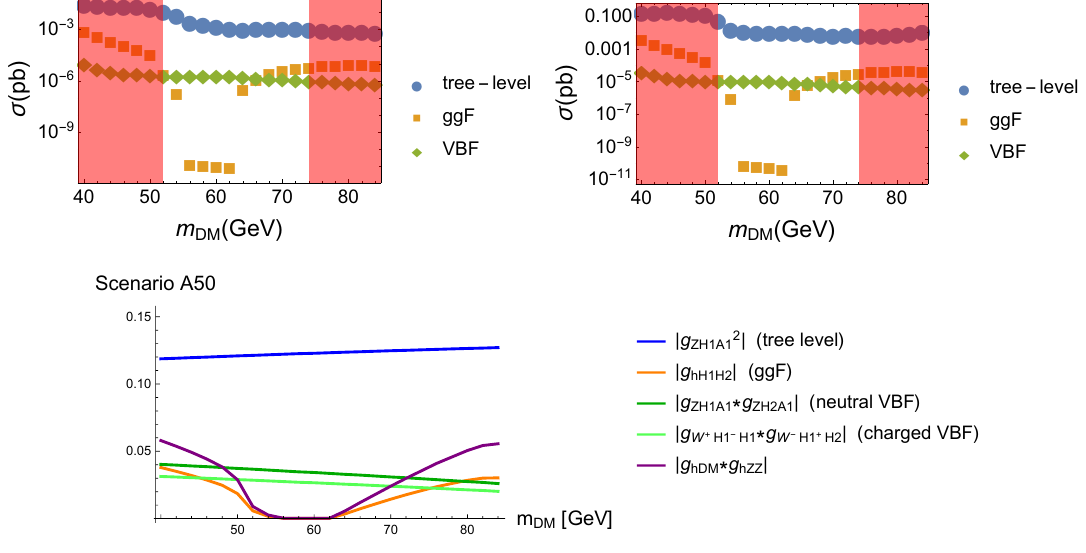
Figure 9 . The anatomy of scenario A50. The plots on the top show the cross sections of the tree-level, ggF and VBF processes with leptonic (left) and hadronic (right) (cid:12)nal states. The red regions are ruled out by LHC ( m DM < 53 GeV) and by direct detection ( m DM > 73 GeV). At the bottom we show the dominant couplings in each process with the same color coding where the Higgs-DM coupling is shown for reference. Note that the g hH appears with the K -factor in the 1 H 2 cross section calculations.